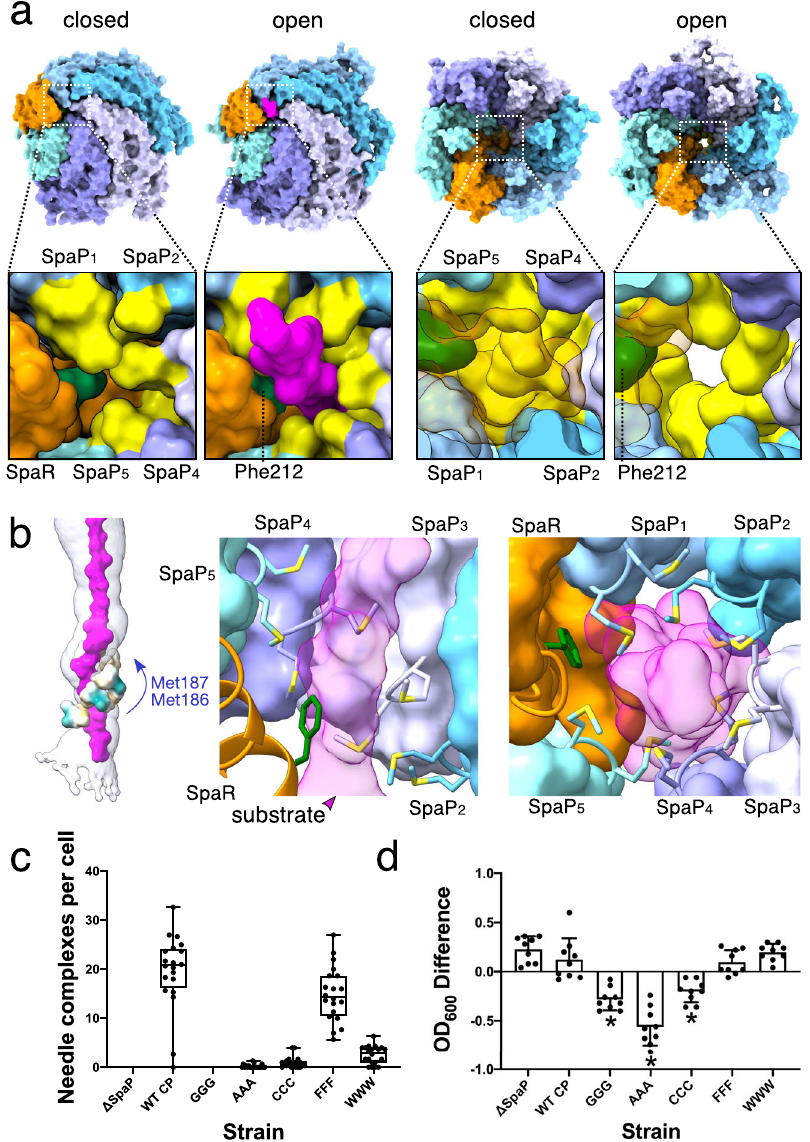
Fig. 4 Opening of the M-gate in the EA facilitates substrate translocation and is crucial for needle complex assembly and cellular fi tness. a Bottom and top views of the EA, with M-gate shown in the lower panels, depicted in surface representation in a closed or open (substrate-engaged) state. SpaP methionine residues 186/7 are displayed in yellow and SpaR Phe212 is in green. SpaR is transparent in the top views. In the top view of the open EA (far right), the substrate has been removed to aid visualization. b Left: surface representations of the M-gate residues Met186/7 colored by hydrophobicity. Middle and right: side and bottom views of the M-gate staircase with Met186/7 and Phe212 depicted in stick representation. c Quanti fi cation of needle complexes ( n = 20 cells) in Salmonella SpaP-knockout strains complemented with SpaP WT (WT CP) or with mutants targeting the conserved 185-Met-Met-Met-187 motif of the M-gate (GGG-WWW). Boxplot whiskers show min and max counts. Lines in the middle of the box represent median values and box limits are the 25th and 75th percentiles. Individual squares represent the number of needle complexes averaged from three counts per cell. Needle complexes were counted by three individuals and averaged, and data represents one of three experiments. d Optical densities of the Salmonella strains in c . Plotted is the mean difference in OD 600 between cultures grown for 6h under T3SS-inducing and non-inducing conditions. n = 9 independent samples examined over three experiments. Individual counts are represented by dots. Error bars represent SD and asterisks represent a signi fi cant difference compared to WT CP (GGG P = 1.33×10 − 6 , AAA P